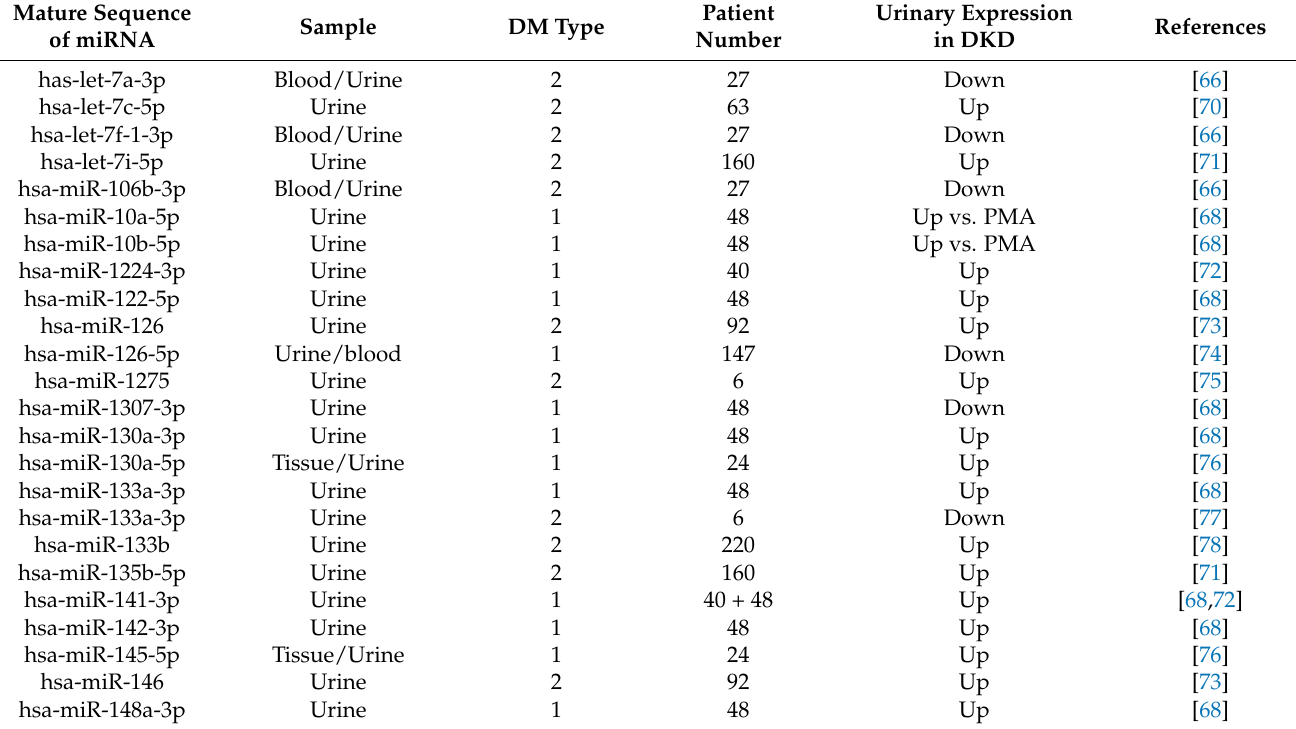
Table 2. Urinary miRNA implicated in human studies related to diabetic kidney disease. Mature Sequence of miRNA